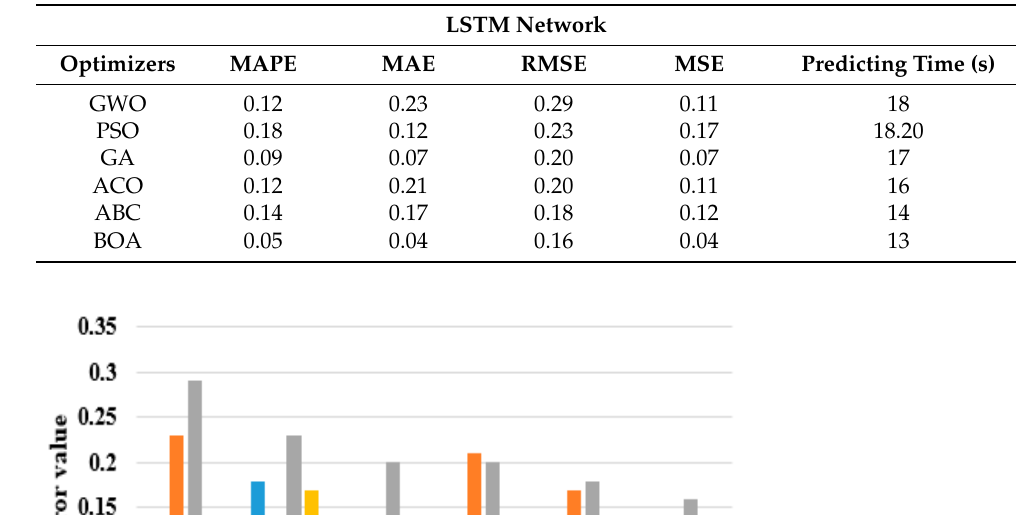
Figure 9. Graphical presentation of the experimental models for the IHEPC dataset. Table 6. Performance of the dissimilar hyperparameter optimizers in the LSTM network on the IHEPC dataset.